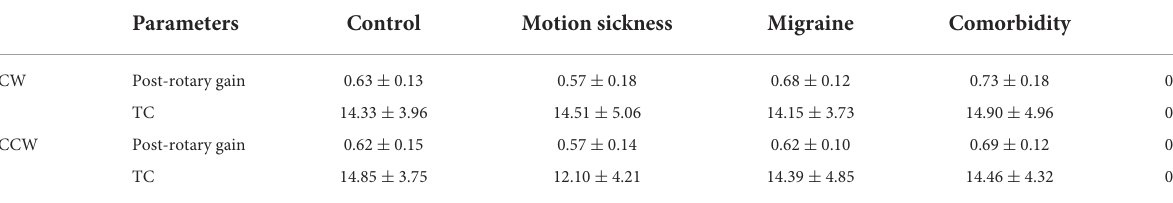
TABLE 4 Comparison for velocity step test for the control group, motion sickness group, migraine group, and comorbidity